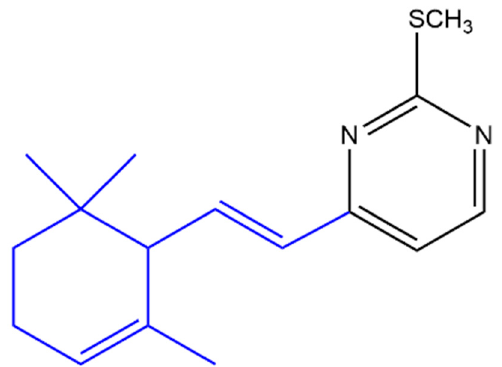
Figure 12. ( E )-2-(Methylthio)-4-(2-(2,6,6-trimethylcyclohex-2-en-1-yl)vinyl)pyrimidine. The α -ionone moiety is shown in blue.